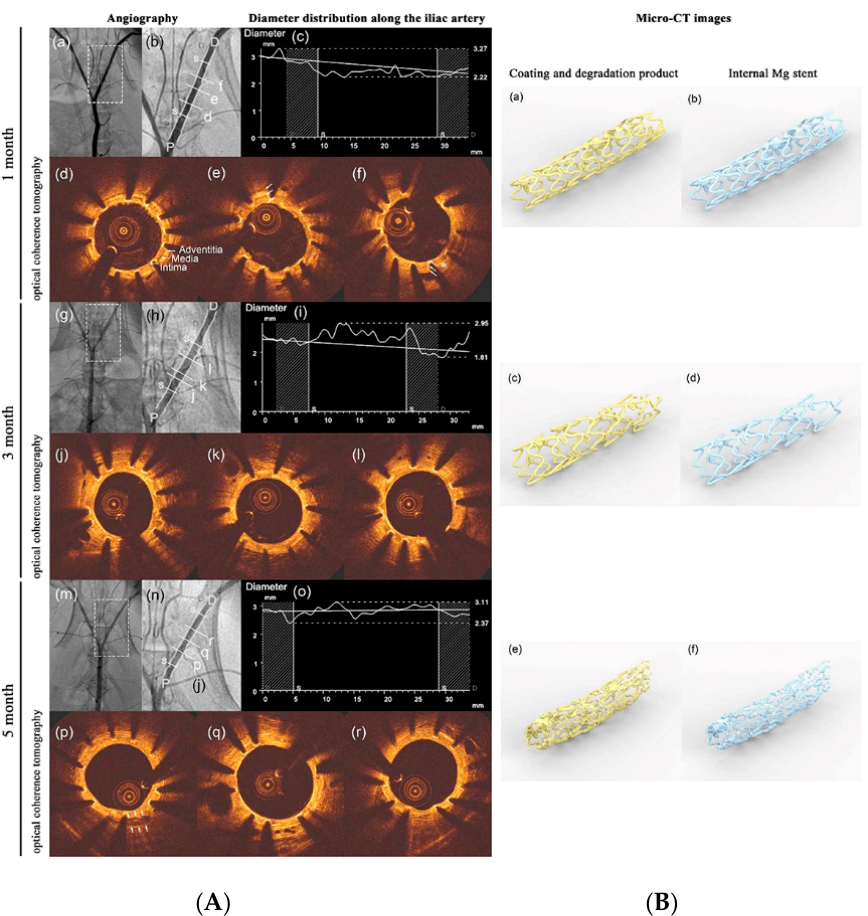
Figure 2. In vivo evaluation using quantitative coronary angiography (QCA), optical coherence tomography (OCT), and high-resolution µ-CT one, three, and five months post-implantation. Left side ( A ): (a,b,g,h,m,n) angiography in the rabbit, and the location of the scaffolded segment. (c,i,o) The distribution of the diameter along the iliac artery. (d-f,j-l,p-r) OCT photographs in the scaffolded segment, showing the complete endothelialization and strut embedding into the vessel wall after one month of implantation. By three months, the attenuations of signal around the edges of the struts remain sharp and the area of the lumen increased. White arrows demonstrate the bright–dark–bright three-layered appearances corresponding to intima, media, and adventitia. The asterisks show the homogeneous signal-rich regions corresponding to fibrous plaques. The double arrows indicate the degraded implant, normal arterial structures, and some calcific plaques after five months. Right side ( B ): µ-CT images. (a,b) One month after implantation, degradation was insignificant. (c,d) By three months, minimal volume loss could be seen. (e,f) At five months, OPT stent considerably degraded. Reprinted with permission from ref. [187]. Copyright 2019, Elsevier.